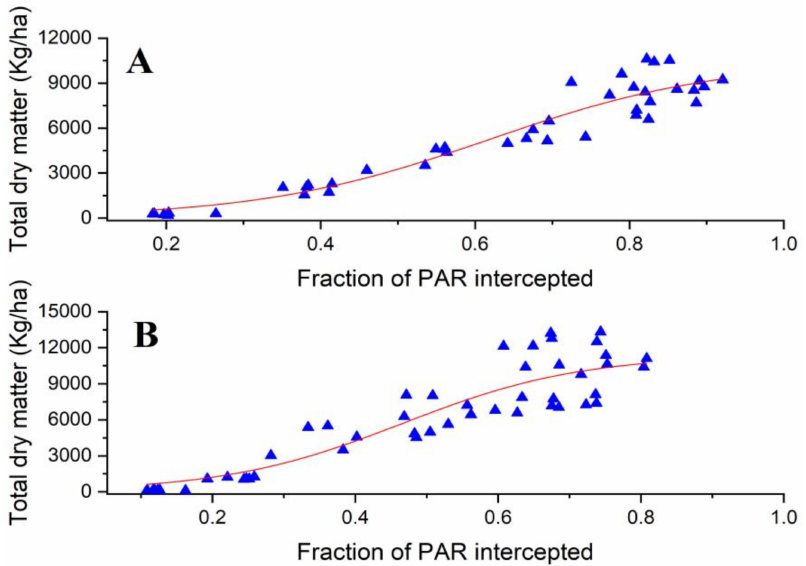
Figure 7. Relationship between the fraction of intercepted PAR and total dry matter accumulation during the whole growing period for six cultivars in 2018 ( A ) and 2019 ( B